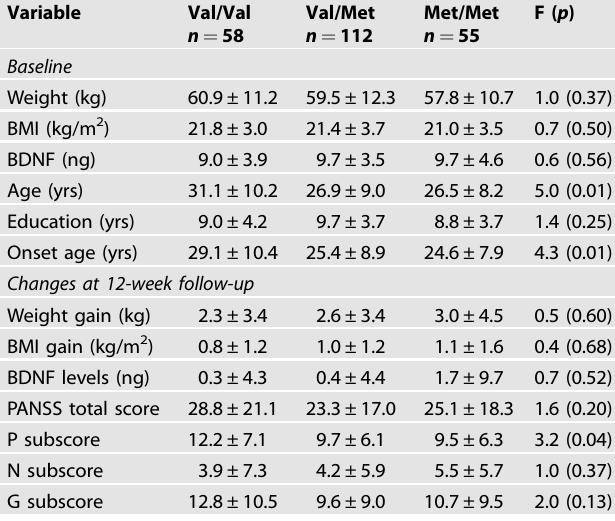
Table 2. Changes of BDNF levels and clinical characteristics across three genotypes in ANFE patients with